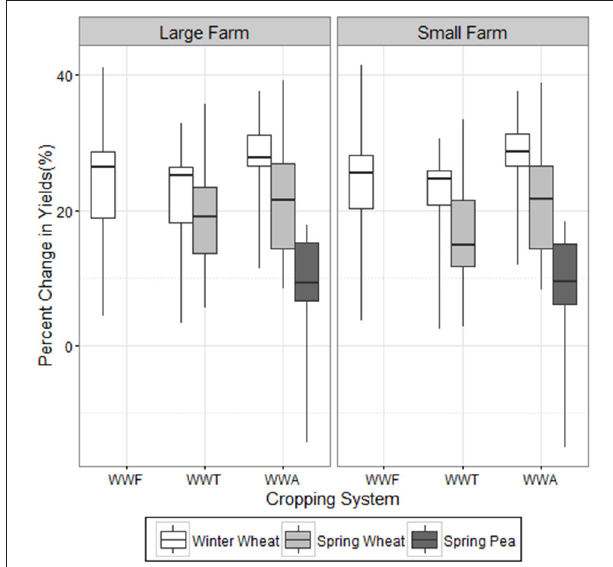
FIGURE 2 | Percent change in simulated yields in 2050 due to climate change, averaged over the REACCH study area, based on downscaled CMIP5 data from 14 global climate models under RCP 4.5. WWF, winter wheat-fallow system; WWT, winter wheat transitional system; WWA, winter wheat annual cropping